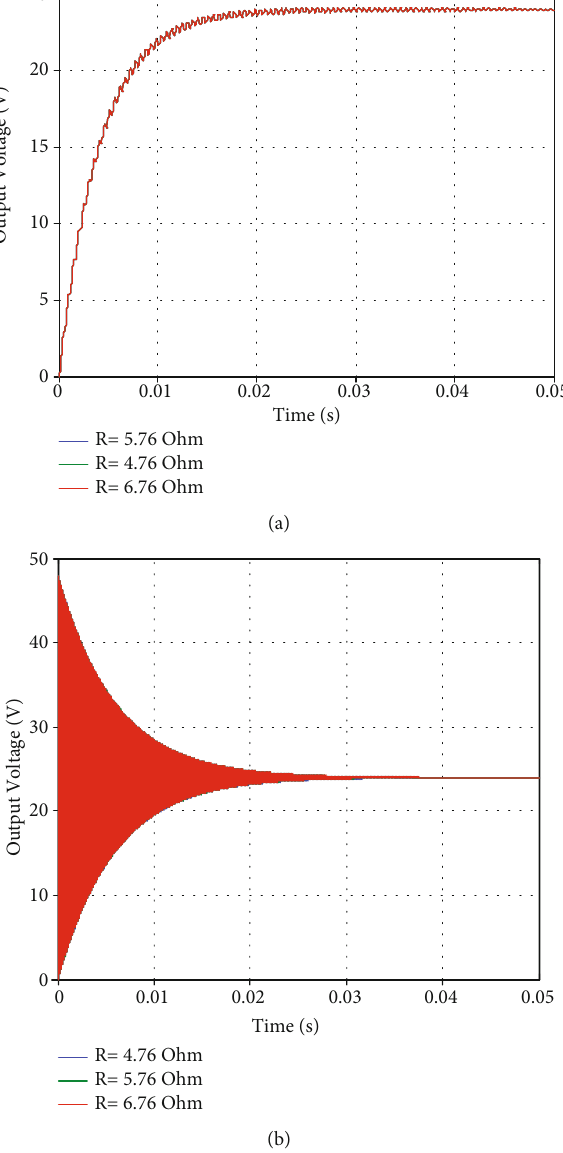
Figure 11: Simulated V results of FKYBC for various R (a) with HPC and (b) with PID o